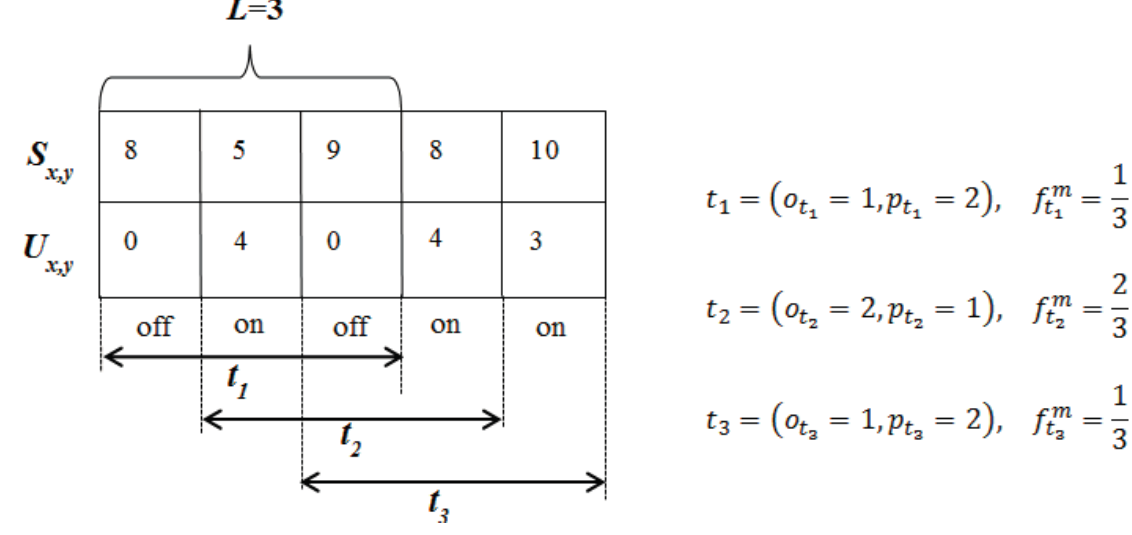
Figure 3. Misbehavior frequency estimation using a time-window